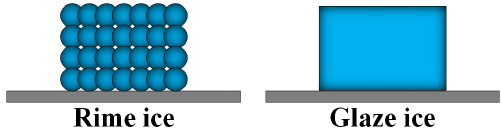
Figure 13. Sketch of the microstructure of rime ice and glaze ice.